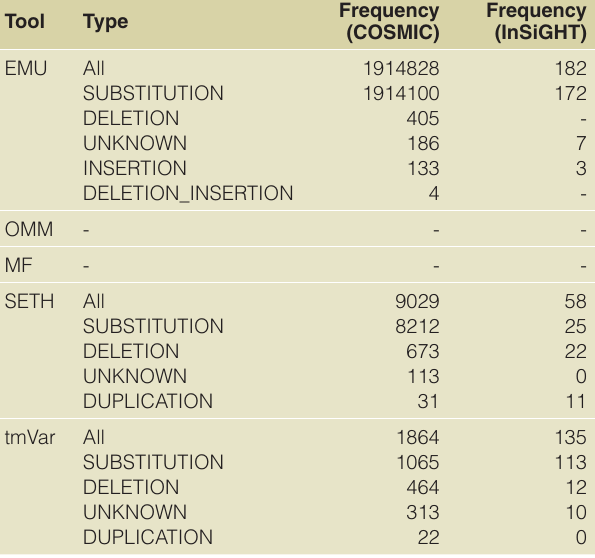
Table 20. DNA variants annotated by each mutation extraction tool, using all the sources from the articles, tool grouped by type. The type of each variant has been annotated using SETH, thus the variant types delivered by SETH are considered. The tools are Extractor of Mutations (EMU), OpenMutationMiner (OMM), MutationFinder (MF), tmVar and SNP Extraction Tool for Human Variations (SETH). A large number of DNA mutations are annotated by EMU. 1887448 of the COSMIC variants are substitutions derived from the supplementary material of a single article, PMID:22622578. Most of these substitutions are provided in terms of chromosome location rather than relative to the gene.